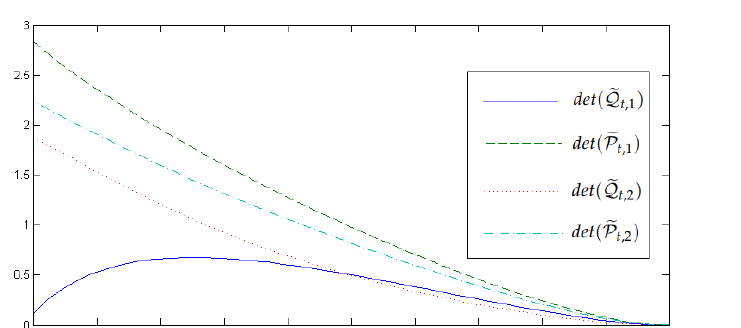
Figure 2. The trajectories of (cid:101) P t ,1 and (cid:101) P t ,2 .